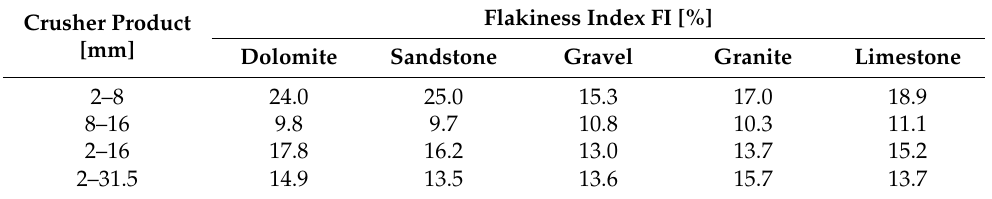
Figure 5. Particle size distribution curves of five comminution products in an impact crusher directed to the WSR screen. Table 5. Contents of irregular grains in individual fractions obtained in an impact